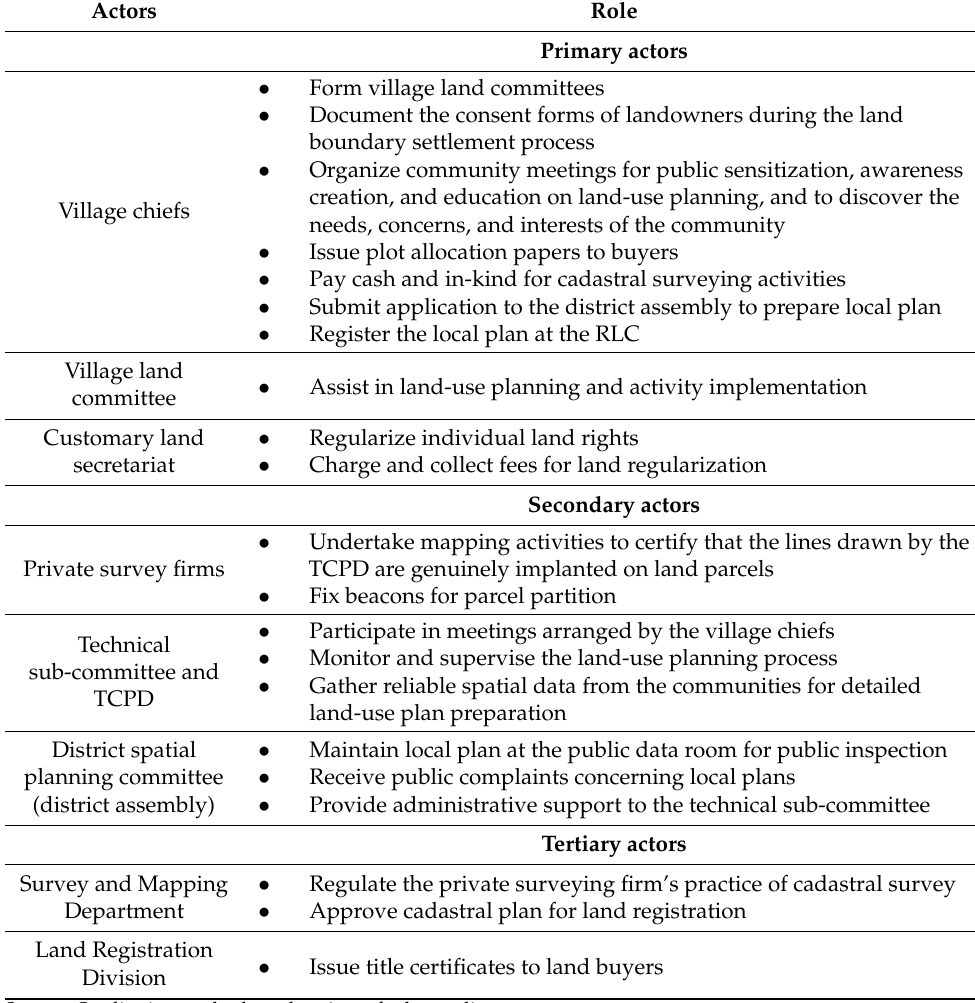
Table 1. Local actors and their roles in land-use planning and cadastral survey in Tinga